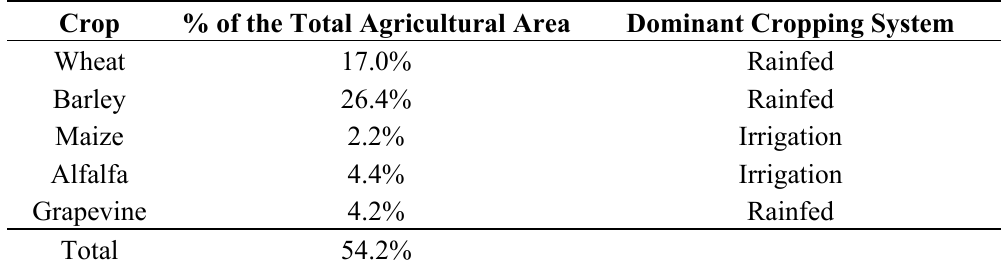
Table 1. Percentage of agricultural area and prevalent crop system in the Ebro basin.